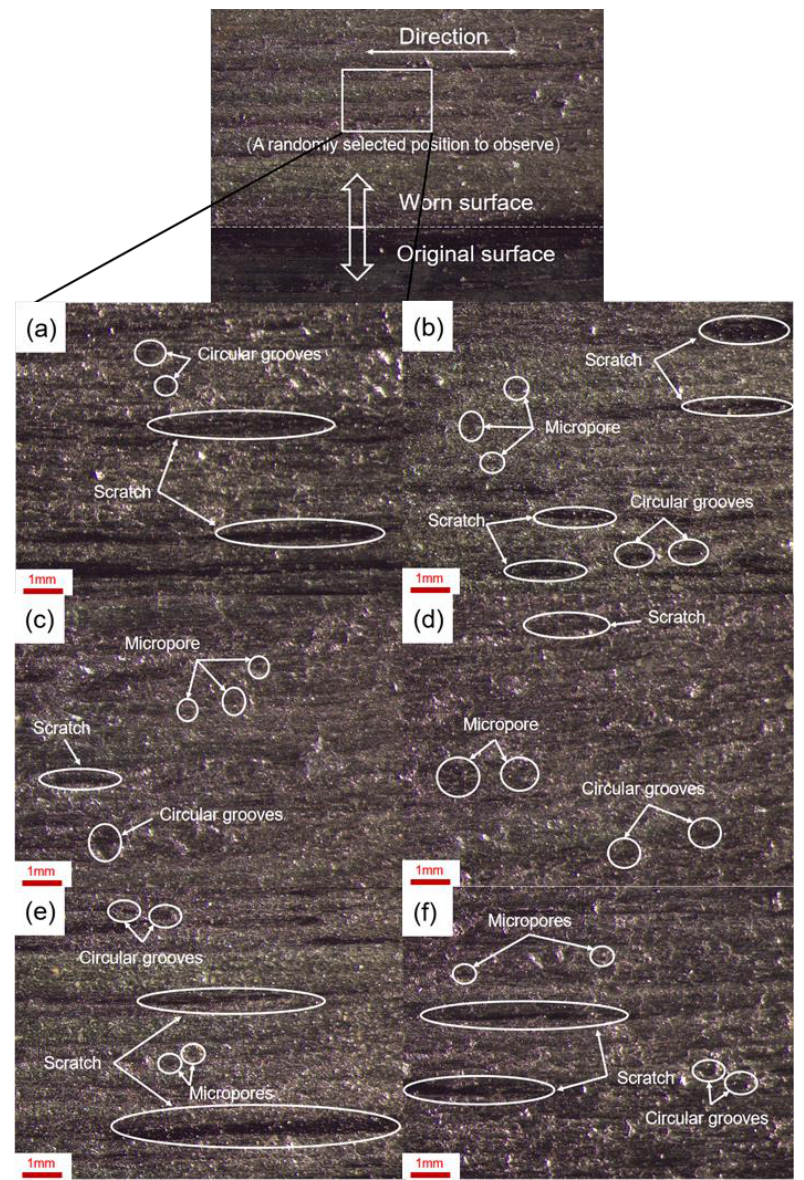
Figure 8. Worn disk surfaces with various particle sizes under no lubricant condition: ( a ) no powder added; ( b ) 0.17 mm; ( c ) 0.28 mm; ( d ) 0.43 mm; ( e ) 0.56 mm; ( f ) 0.90 mm. added; ( b ) 0.17 mm; ( c ) 0.28 mm; ( d ) 0.43 mm; ( e ) 0.56 mm; ( f ) 0.90